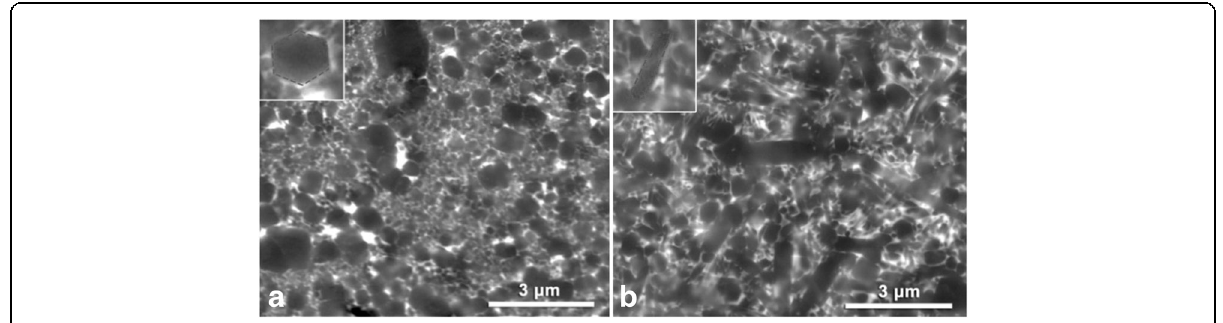
Fig. 4 Microstructure of Si 3 N 4 SPSed at a 1550 °C and b 1650